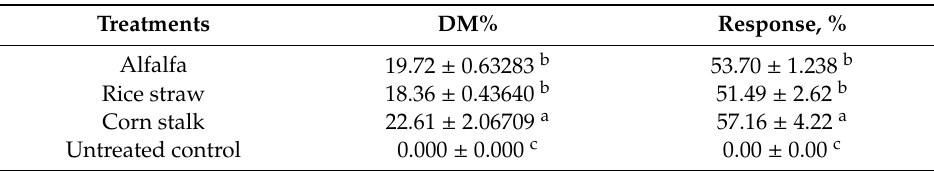
Table 2. In vitro dry matter digestibility; means and standard